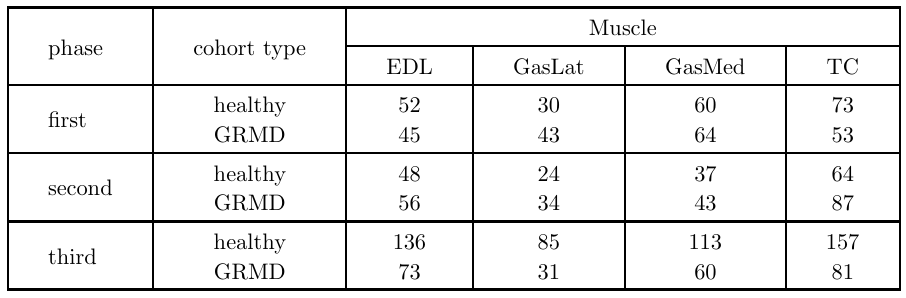
Table 2. Numbers of ROIs used in the experiments